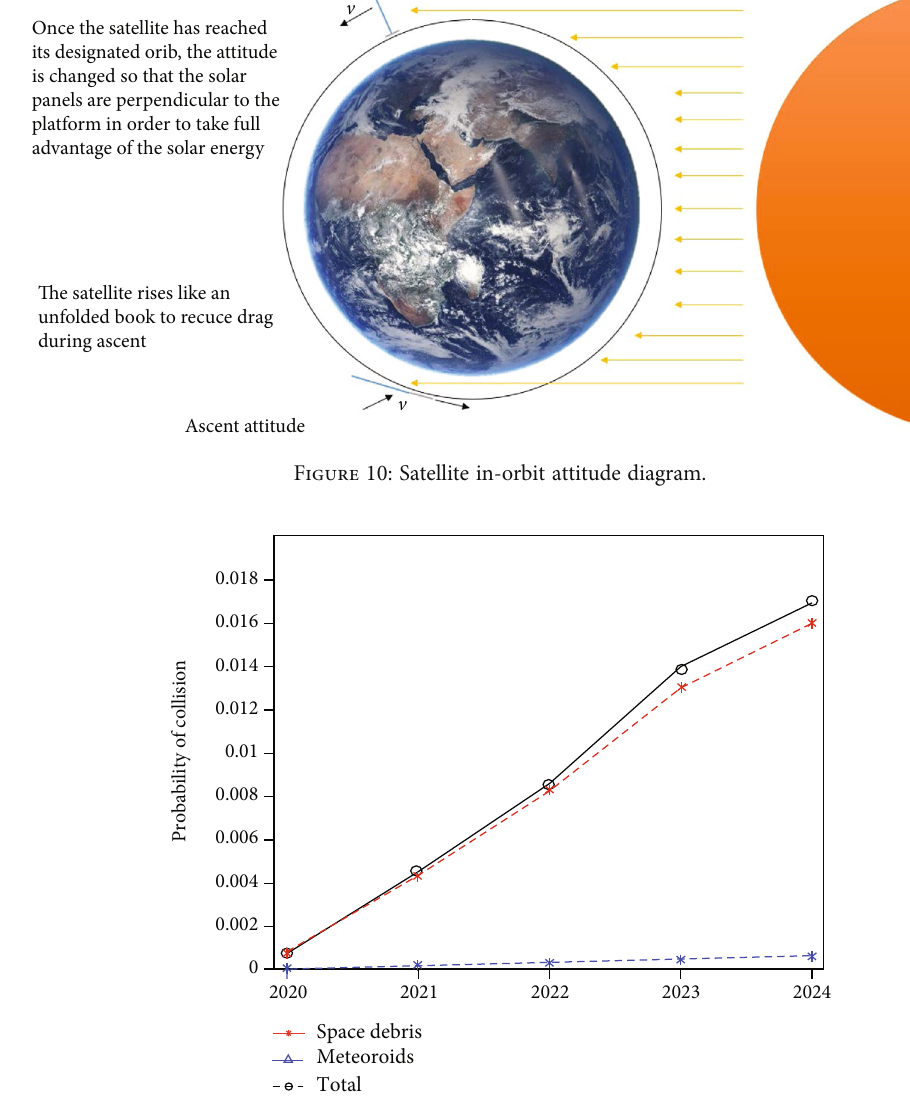
Figure 11: Collision probabilities for all years (space debris represents the collision probability of space debris, and meteoroids represent the collision probability of